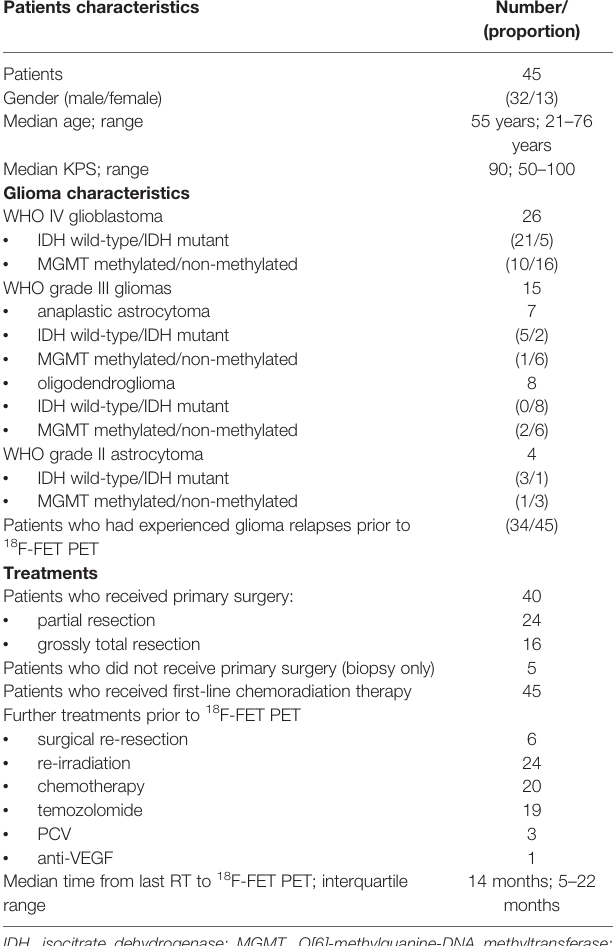
TABLE 1 | Cohort characteristics. Patients